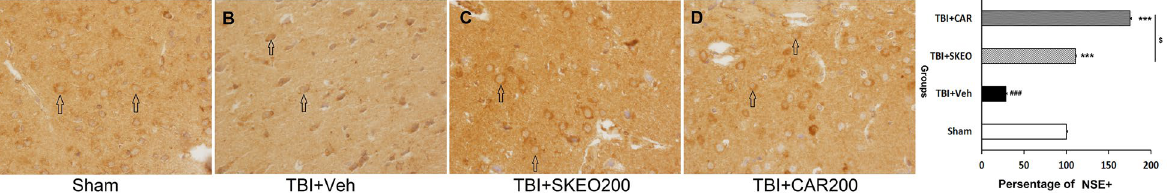
Figure 6. ( A – D ) IHC staining for NSE in the rat brain (×40). ( A ) Sham; arrow indicates the normal neurons. ( B ) 24 h after TBI; arrow indicates the degenerated neurons. ( C , D ) TBI + SKEO200& TBI + CAR200; arrow indicates the viable neurons. The scale bar illustrates the means ± SEM percentages of neuron-specific enolase (NSE from different groups. ### p < 0.001 compared to the sham group, ***p < 0.01 compared to the TBI group, and $ P < 0.05 represents significant difference between TBI + CAR and TBI + SKEO. TBI: Traumatic brain